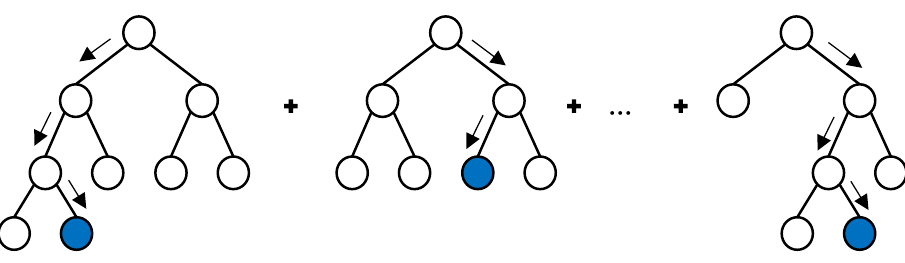
Figure 4. Illustration of the classification and regression trees (CARTs) ensembles.